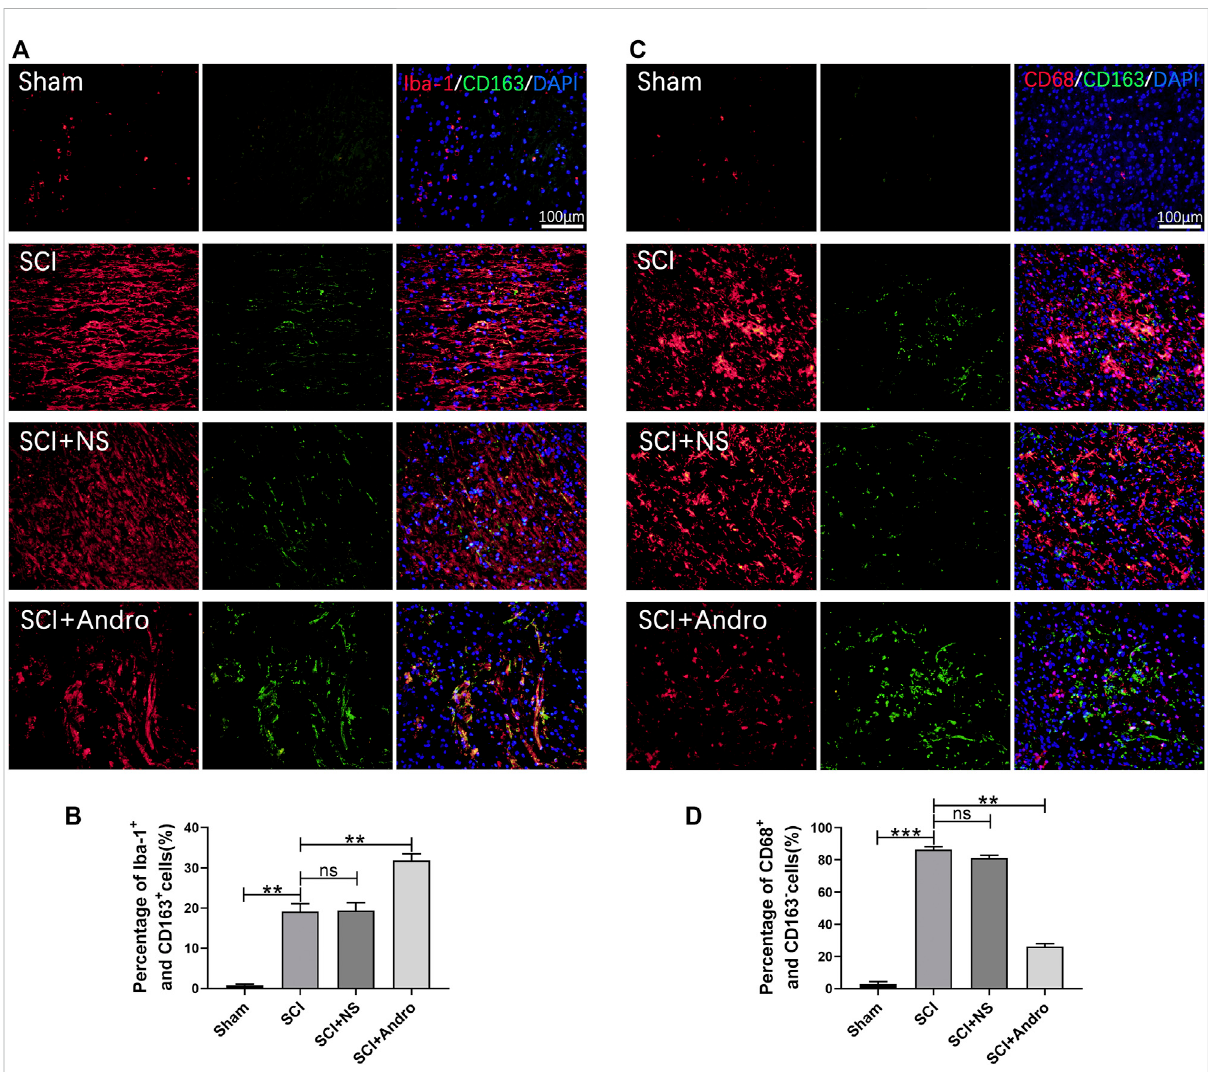
FIGURE 4 Andro treatment promoted microglia polarization toward the M2 phenotype after SCI. (A – B) Co-immuno fl uorescent staining of Iba-1 (red)/ CD163 (green)andrelativequanti fi cationofIba-1 + /CD163 + cellsinspinal cord tissues28days post-SCI. (C – D) Immuno fl uorescentstainingofCD68 (red)/CD163 (green) and relative quanti fi cation of CD68 + /CD163 - cells in spinal cord tissues 28 days post-SCI. Data are presented as the mean ± SD, n = 3 per group.* p < 0.05,** p < 0.01,*** p < 0.001, ns p ＞